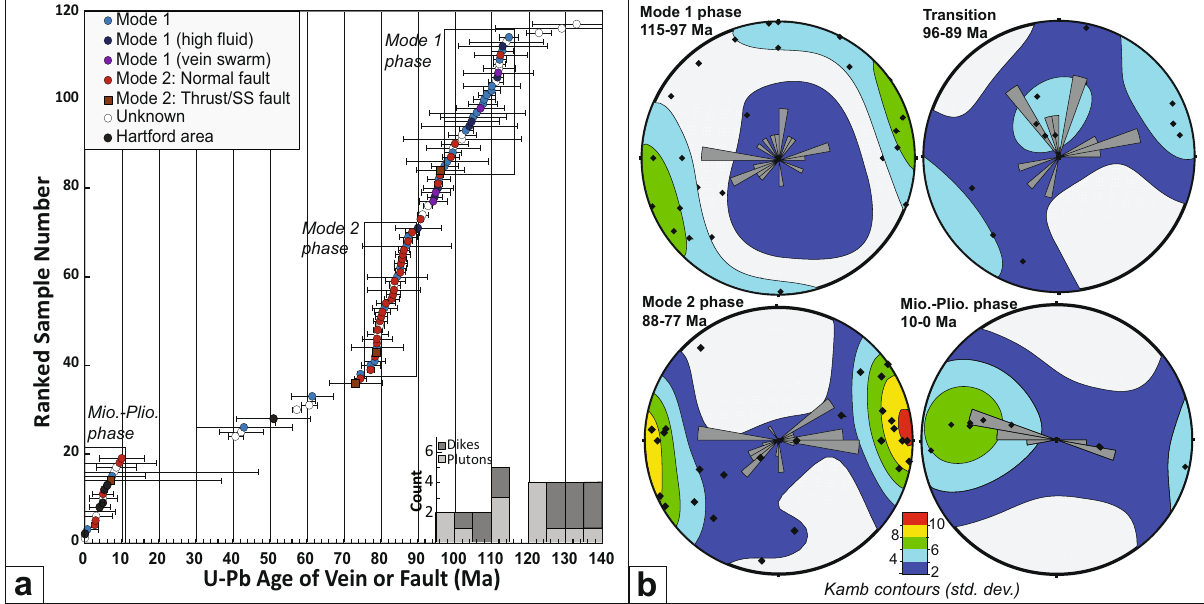
Kamb contours (std. dev.) Fig. 2 Chronology of fracturing and inferred σ 3 stresses. a Chronology of dated calcite samples overlain with histogram of dated magmatic intrusions in the Champlain Valley. Data points represent the mean U-Pb isochron age and its associated 2 σ error as computed by the Isoplot v4.15 AgeEr7Corr function. The onset of Cretaceous fracturing begins after a > 300 Myr tectonic hiatus and is divided into mode 1 and mode 2 phases based on the dominant style of fracturing observed during each time interval. Both phases of fracturing post-date initial magmatism and the mode 2 phase post-dates all of the magmatism in the Champlain Valley. The Miocene-Pliocene phase records a tectonic reawakening likely associated with the development of modern relief in northern New England. b σ 3 stresses inferred from fi eld study of the dated faults and fractures. Note the relatively scattered stress directions for the Mode 1 phase compared with the more clustered E-W orientations for the Mode 2